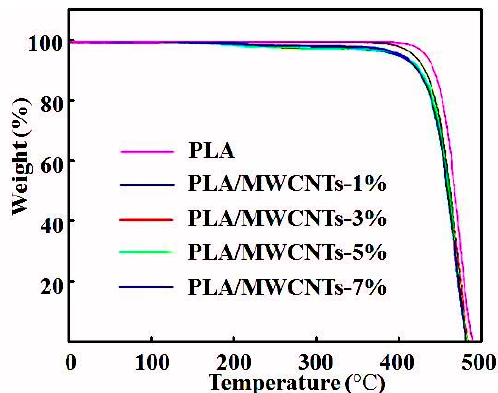
Figure 4. Thermogravimetric analysis (TGA) thermograms of PLA and the PLA/MWCNTs composite materials.